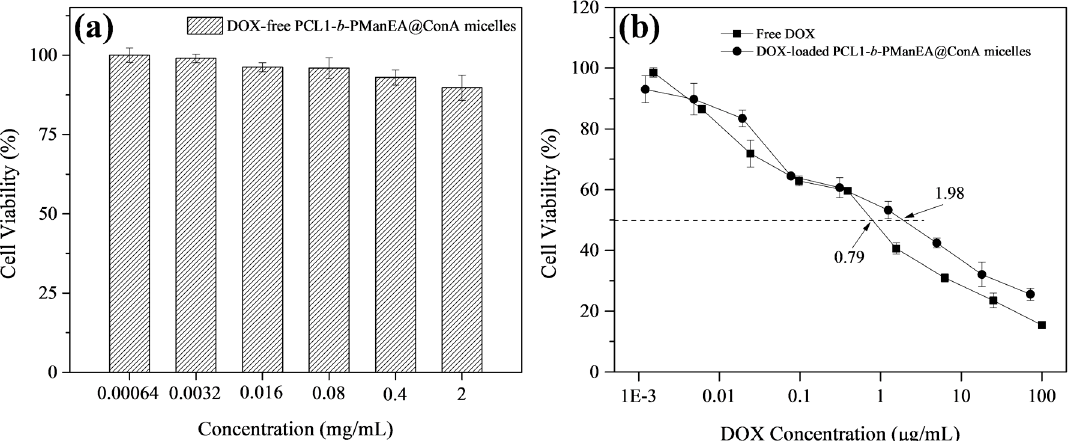
Figure 7. Viability of UMUC3 cells after incubation with: ( a ) DOX-free PCL1- b -PManEA@ConA micelles; and ( b ) free DOX and DOX-free PCL1- b -PManEA@ConA micelles. Cells were exposed to the free DOX or micelles for 2 h and further cultured with fresh DMEM for 72 h.